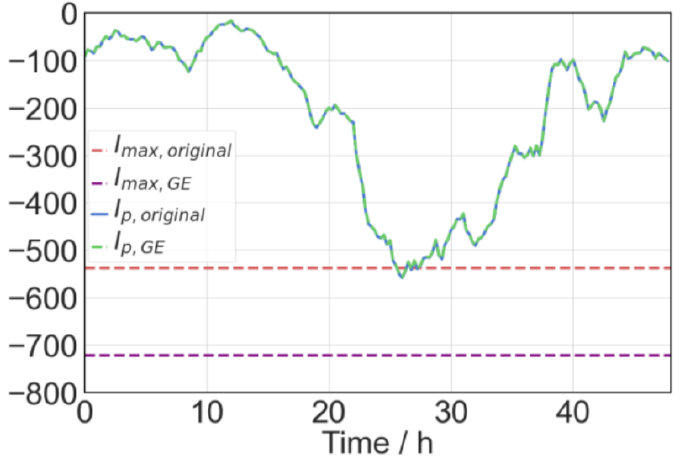
Figure 13. Current flow through the line 6 initially (blue trace) and after grid expansion (green trace).